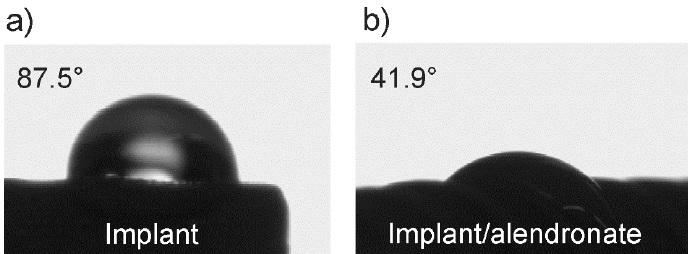
Figure 2. The water drops and contact angle values on ( a ) the as-received implant surface and ( b ) the alendronate-modified implant surface.